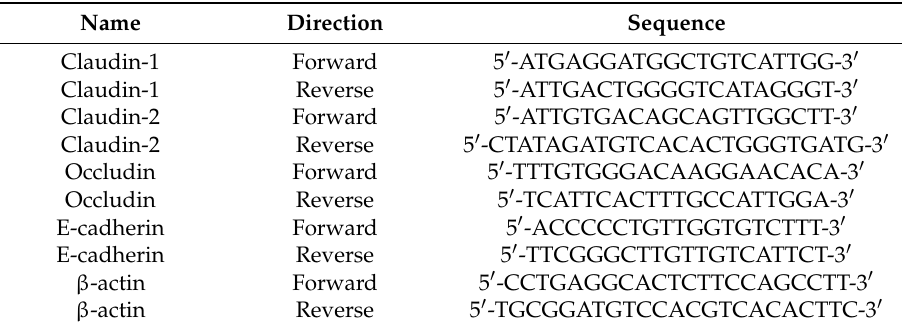
Table 1. The threshold cycle (Ct) for each PCR product was calculated with the instrument’s software, and Ct values obtained for claudin-1 and -2 were normalized by subtracting the Ct values obtained for β -actin. The resulting ∆ Ct values were then used to calculate the relative change in mRNA expression ∆ Ct(treatment) − ∆ Ct(control)) as a ratio (R) according to the equation R = 2 − ( . Table 1. Primers for polymerase chain reaction (PCR) amplification. Name